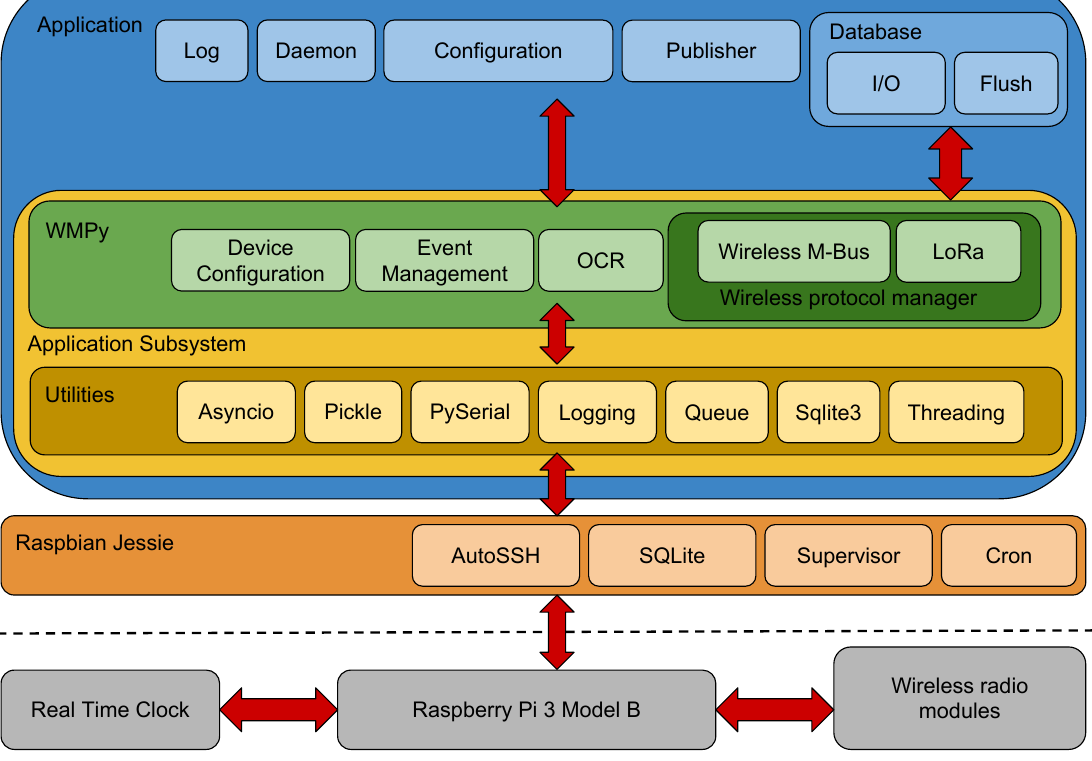
Figure 3. SWaMM Edge software architecture of